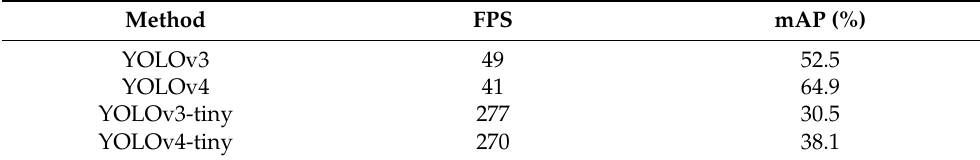
Table 1. YOLO comparison chart [21].